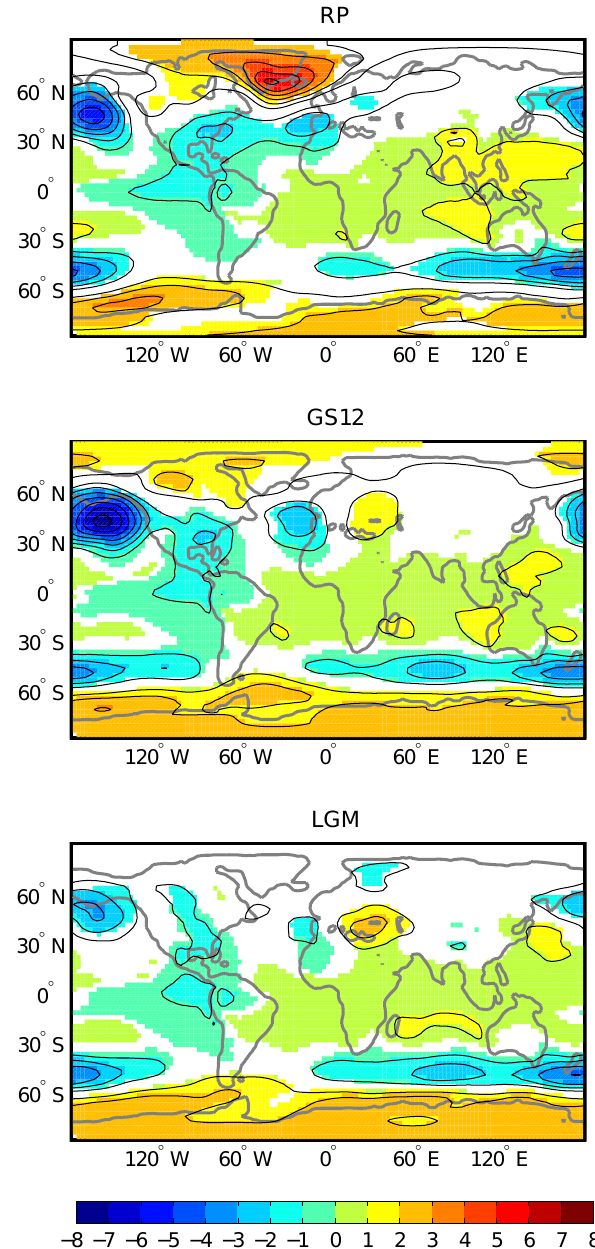
Fig. 7. JFM El Ni˜no – Southern Oscillation teleconnections of mean sea level pressure shown as differences between seasonal averages over El Ni˜no years and La Ni˜na years for the RP (upper panel), the GS12 (middle panel), and the LGM (bottom panel) simulations. Units are hPa, contour interval 1hPa (excluding the 0hPa contour). In shading, statistically significant differences (at the 95% level) are displayed. The coastline is defined at 20% of the land